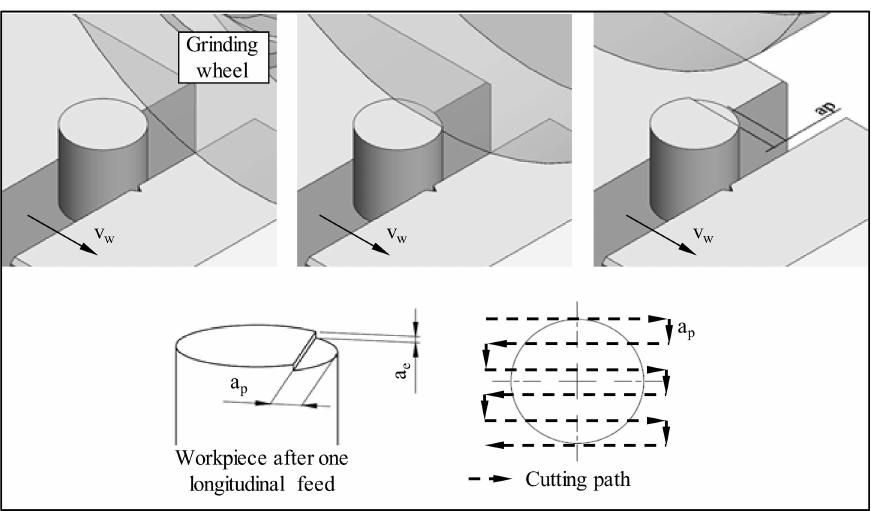
Figure 1. Sketch of the grinding operation used in the experimental